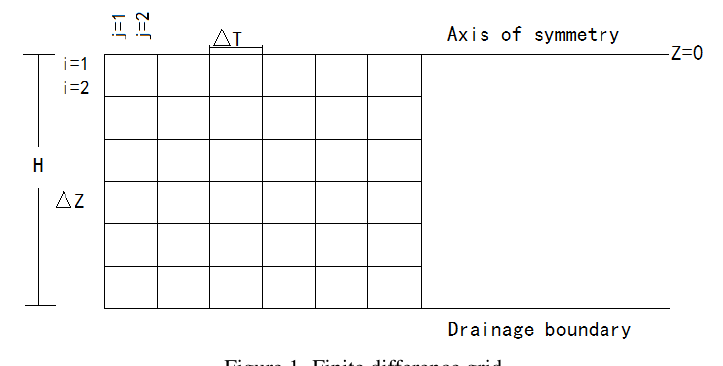
Figure 1. Finite difference